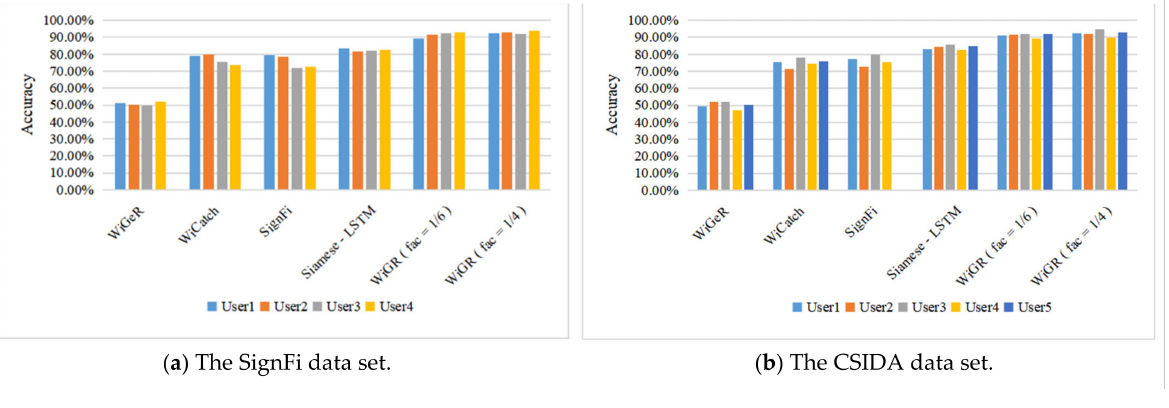
Figure 8. Accuracy of cross-user evaluation.